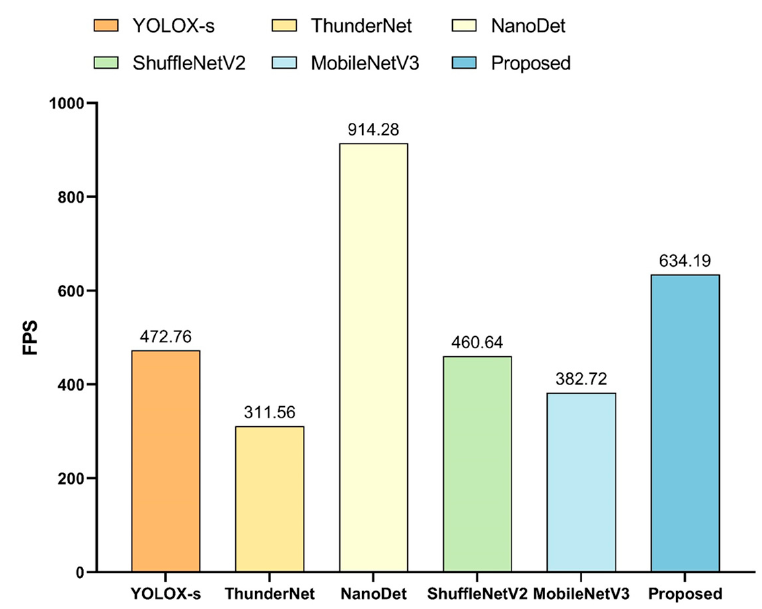
Figure 19. Comparison of detection speed of different networks.